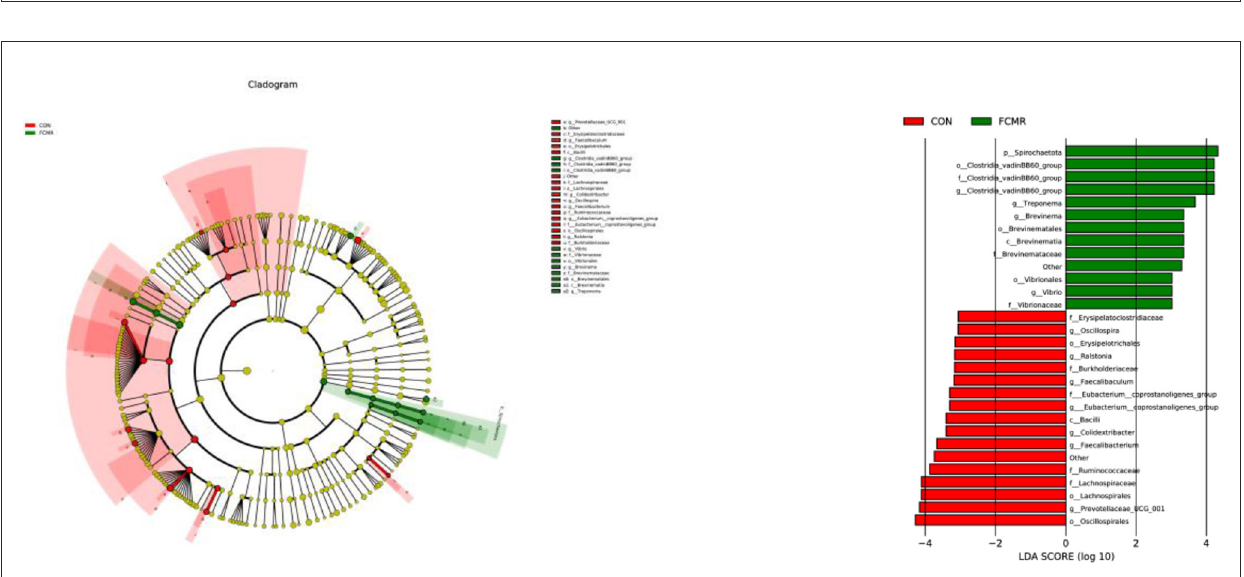
FIGURE5 The microbiomes of the two groups were described using LEfSe and LDA analyses based on ASVs disparities in the (log LDA > 3.0; n = 6).